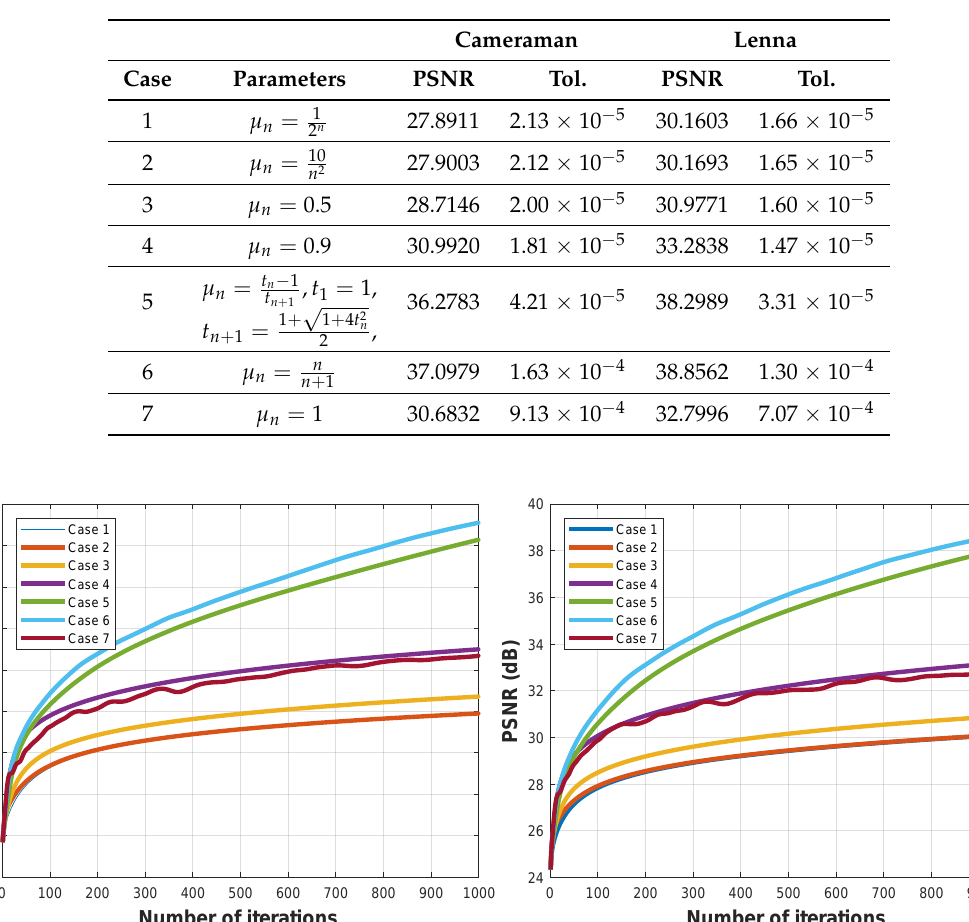
Table 2. Effective parameters of our method for image restoration.